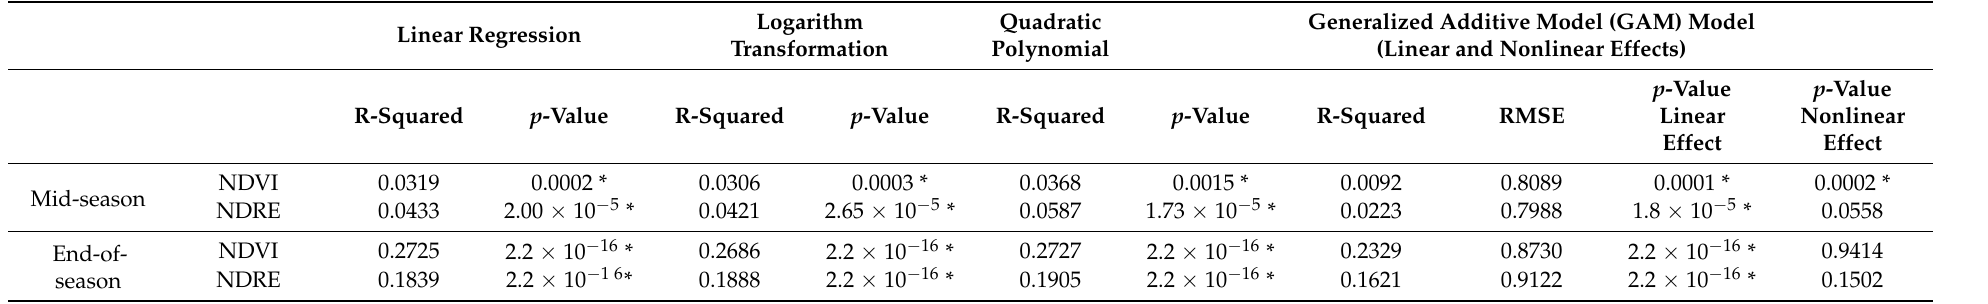
Table 3. Linear model vs. nonlinear model for lignin. Results show both mid-season and end-of-season. Normalized difference red edge (NDRE) and normalized difference vegetation index (NDVI) were used for the modeling. p -values with * are